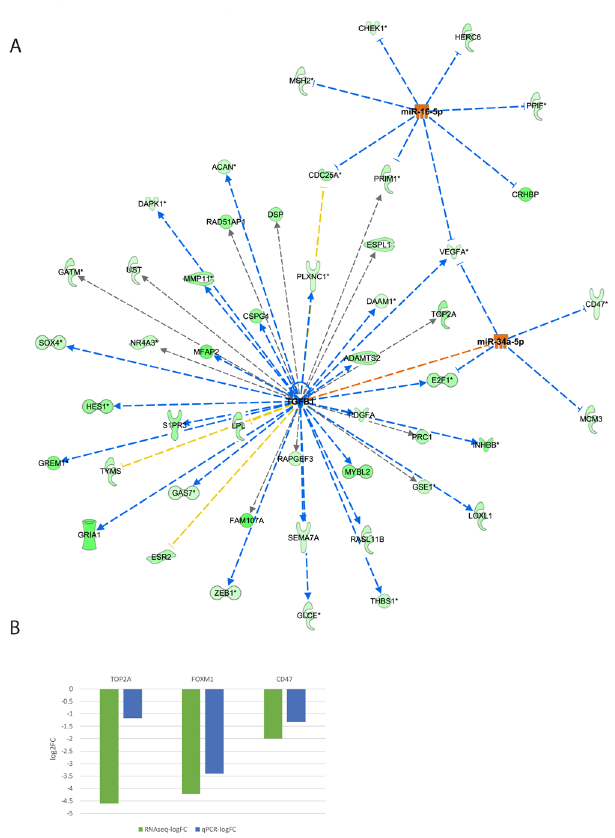
Figure 4. ( A ) The resultant DE miRNAs were analyzed through the use of IPA (Ingenuity Pathway Analysis, QIAGEN Inc., https://www.qiagenbioinformatics.com/products/ingenuitypathway-analysis) 19 to examine the crosstalk between the TGFB 1 signaling pathway and miR-34a and miR-16a-5p (seed of miR-424-5p). We revealed a number of genes and pathways, most notably VEGFA , that are reciprocally regulated by these negatively correlated transcription regulators. ( B ) Total mRNA was purified from CCs denuded from GV COC and M2 COC aspirated during IVF procedures. The mRNAs were subjected to qPCR in duplicate with the examined genes and ACTB primers. Gene expression was calculated relative to the ACTB level in the same sample and expression levels were compared using Student’s t-test. The difference reached p = 0.006 for FOXM1, p = 0.01 for TOP2A and p = 0.08 for CD47. RNAseq (green) and qPCR (blue) results are presented as log2-fold change between COC M2 and COC GV